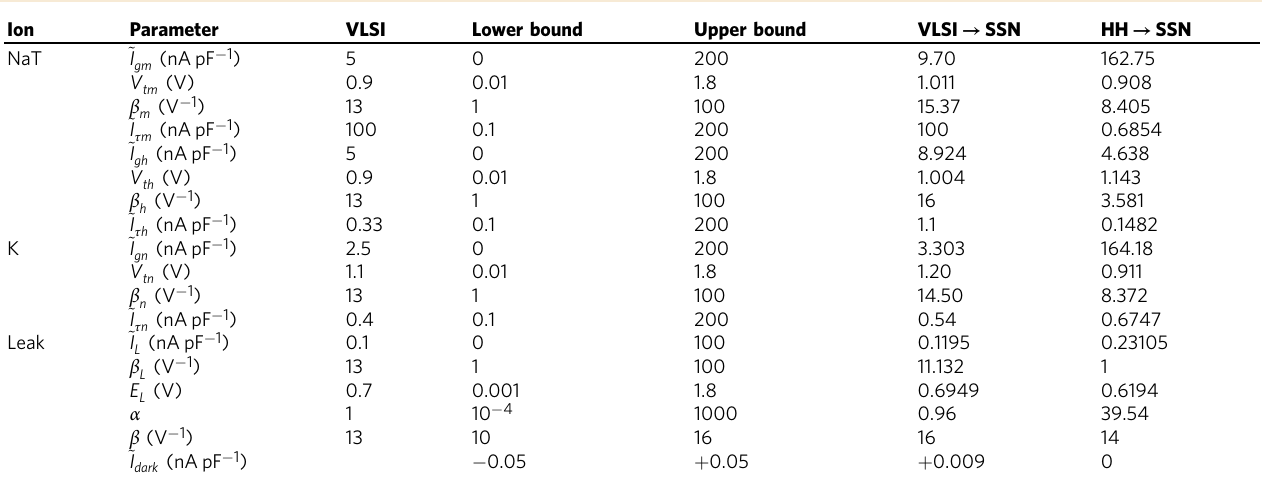
Column 3 lists the voltage thresholds, current biases and sigmoidal parameters, which are set in the VLSI micro-circuit implementing the SSN model in silico. Columns 4 and 5 specify the parameter search intervals used in data assimilation. Column 6 lists the SSN parameters inferred by assimilating the membrane voltage of the VLSI neuron (twin experiment). These parameters ought to be the sameastheVLSIparameters(column3).Column7givestheSSNparametersestimatedbyassimilatingthemembranevoltagesynthesizedbytheHodgkin – Huxley(HH)model(SupplementaryTable1). I inj had units of nA, and V , V m , V h and V n units of V